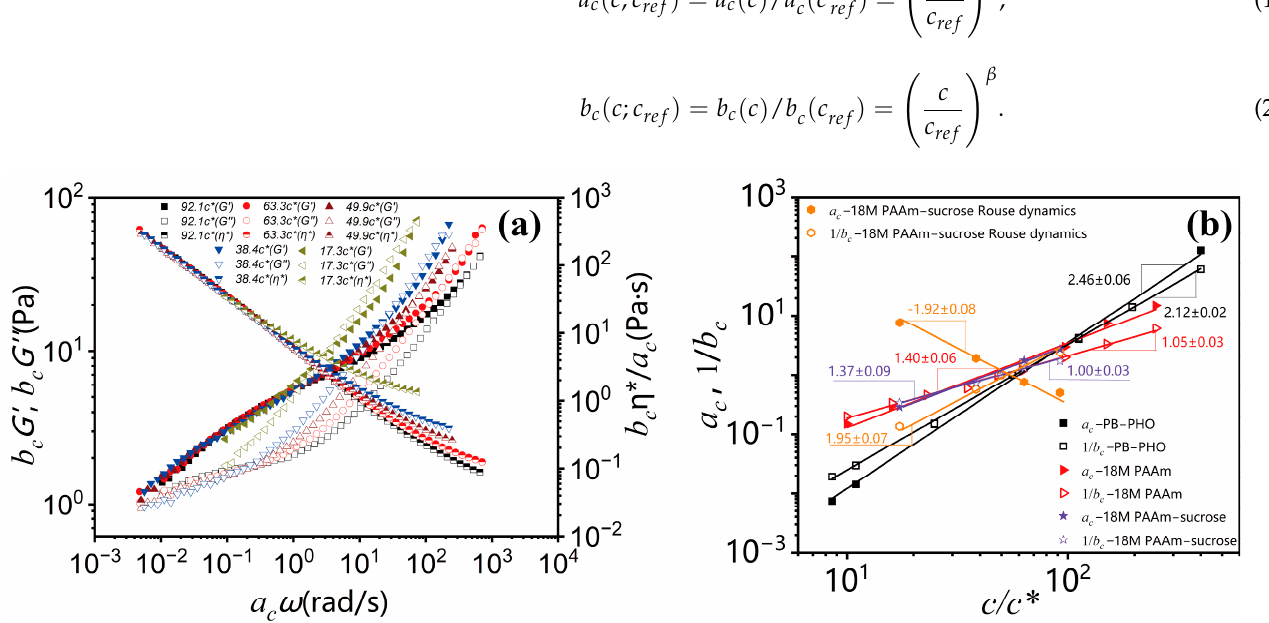
Figure 3. ( a ) A master curve of G ′ ( ω , c/c *), G ″ ( ω , c/c *) complex viscosity η *( ω , c/c *) with c ref = 49.9 c * superimposed with respect to the terminal entanglement dynamics; ( b ) plots of shifting factor a c and 1/ b c against concentration c / c * and in comparison with PB–PHO [4] and 18M PAAm–water binary solutions, respectively.